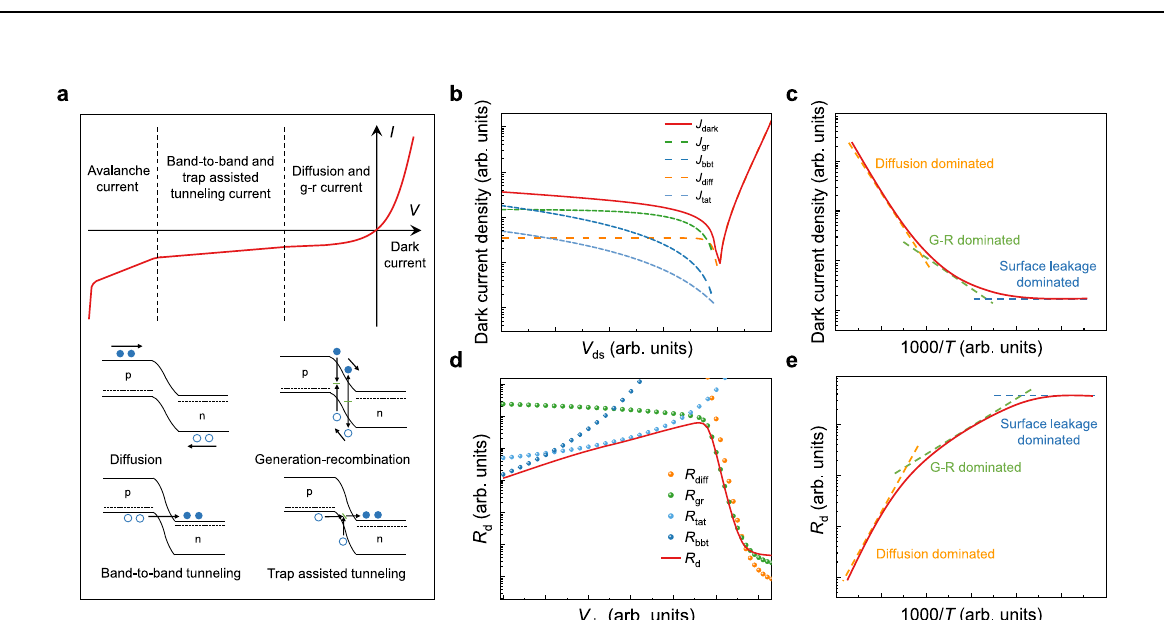
Fig. 4 | Characterization and analysis of dark current of 2D photodetectors. a Typical dark current mechanism, the dashed lines, fi lled and empty circles and arrows represent quasi-fermi level, electrons, holes, and carrier transport direc- tion. b Characterization and analysis of dark current for UV-VIS photodetectors. The solid red line is the I d – V characteristic curve measured with a typical VIS photodetector.Thegreen,darkblue,orange,andlightbluedashedlinesrepresent the fi tted current components of generation-recombination, band-to-band